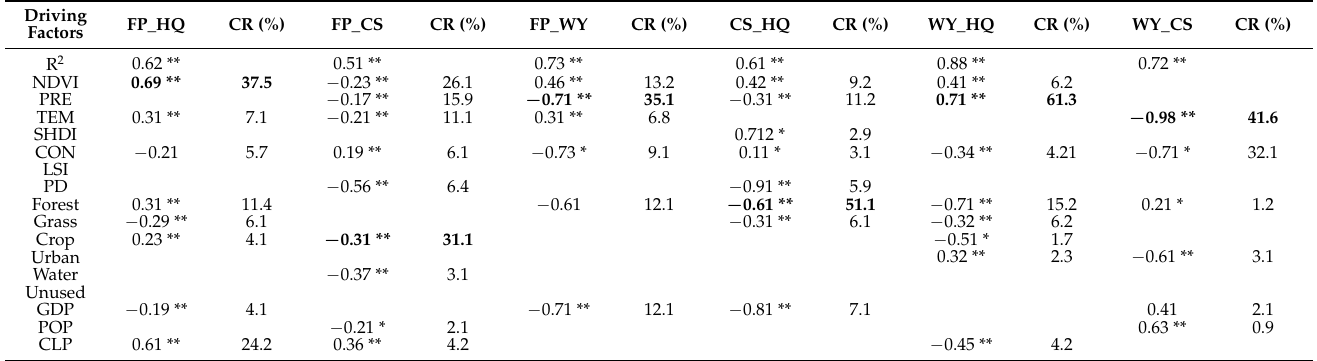
Table 5. Results of the 2010 automated linear modeling model.